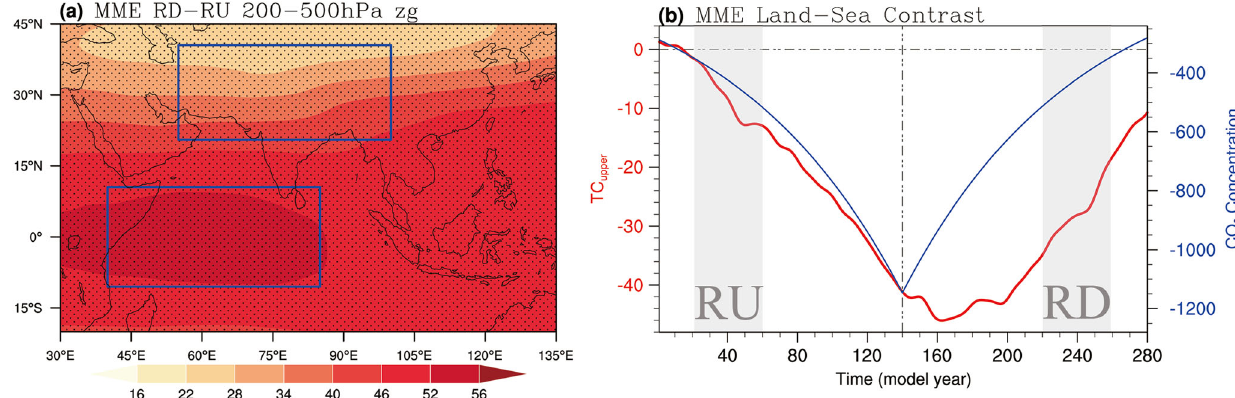
Fig. 8 The response of the thermal contrast. a The difference in 200 – 500 hPa thickness (shadings; unit: m) between the RU (21 – 60) and RD (220 – 259) periods. b Time series of the land – sea thermal contrast (TC upper ; red line; unit: m) and CO 2 concentration (blue line; unit: ppm). The 200 – 500 hPa thickness difference between the land (northern blue box in ( a ), 20.5° – 40.5°N, 55° – 100°E) and ocean (southern blue box in ( a ), − 10.5° – 10.5°N, 40° – 85°E) is de fi ned as the land – sea contrast index. A 3-point (1/4,1/2,1/4) fi lter with 40 times is performed on the land-sea contrast index. The atmospheric CO 2 concentration is multiplied by − 1 to facilitate comparison. Published in partnership with CECCR at King Abdulaziz University npj Climate and Atmospheric Science (2023)